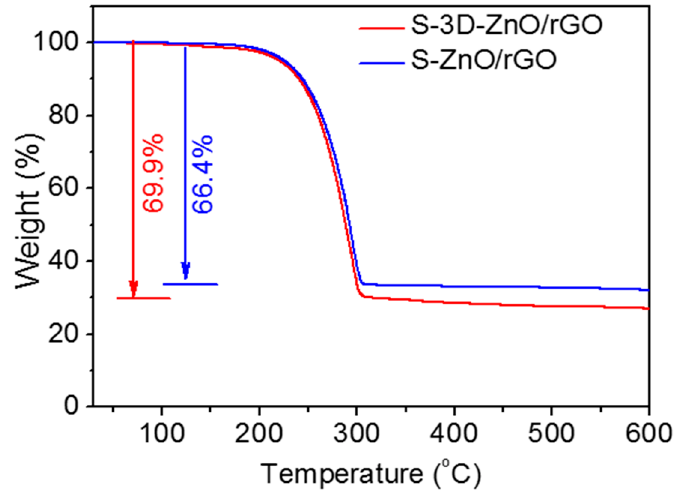
Figure 7. TGA curves of S-ZnO/rGO and S-3D-ZnO/rGO composites.